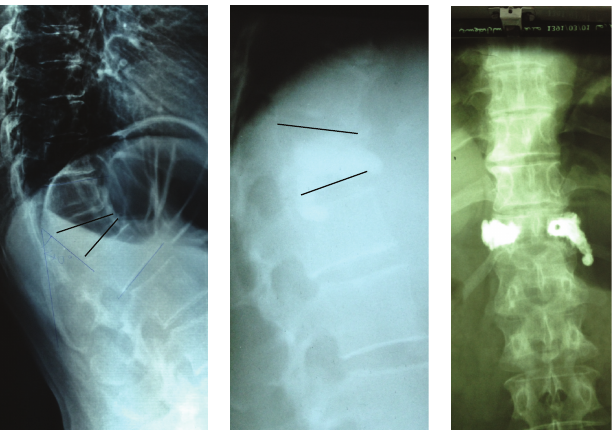
Figure 5: Percutaneous kyphoplasty in a 50-year-old female. Note that cement extravasated into the paravertebral